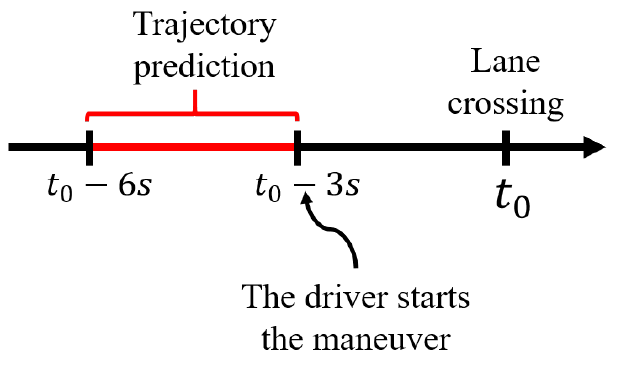
Figure 5. Timeline of the predicted